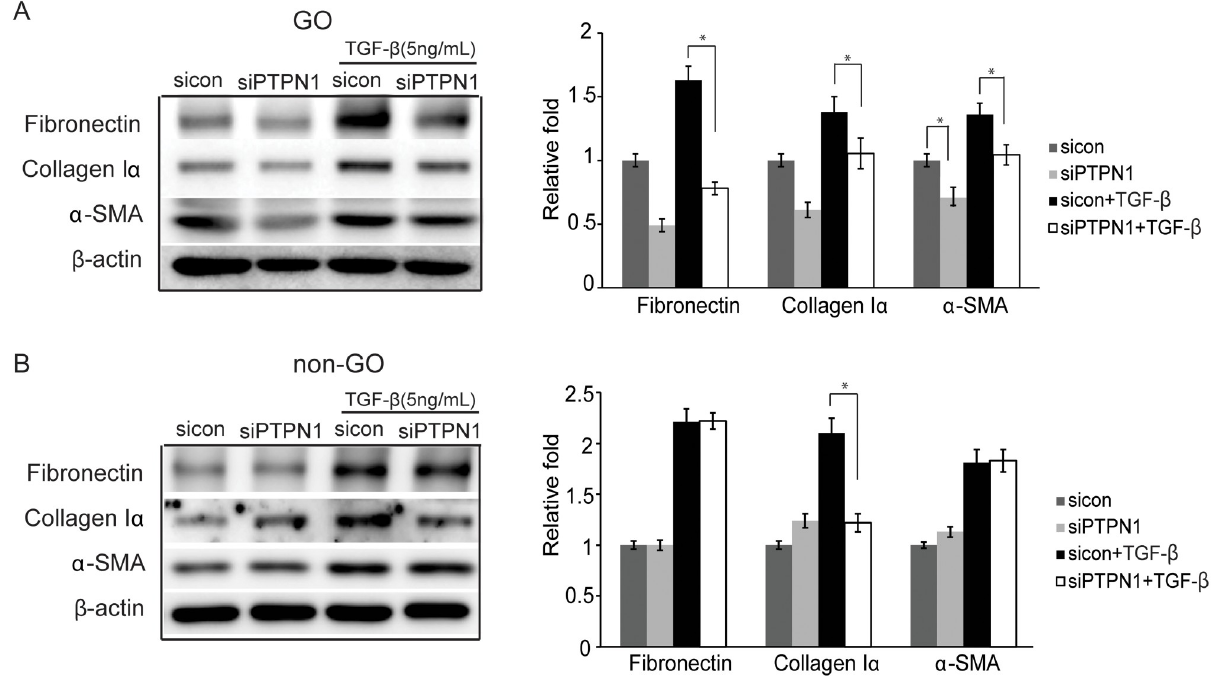
Fig 4. Effect of PTP1B suppression on the fibrosis of orbital fibroblasts. Orbital fibroblasts from GO and non-GO patients transfected with sicontrol or siPTPN1 for 24 hours were exposed to TGF- β (5 ng/mL) for 24 hours. Cell lysates of GO fibroblasts (A) and non-GO fibroblasts (B) were subjected to western blot analysis of fibronectin, collagen I α , and α -SMA protein expression. Experiments were performed in three GO cell strains and non-GO cell strains taken from different individuals. Data in the columns indicate the mean density ratio ± SD by densitometry normalised to the level of β - actin in the same sample. Representative gel images are shown. Differences between sicontrol and siPTPN1 are indicated ( � p < 0.05). See S3 Fig for uncropped blots.